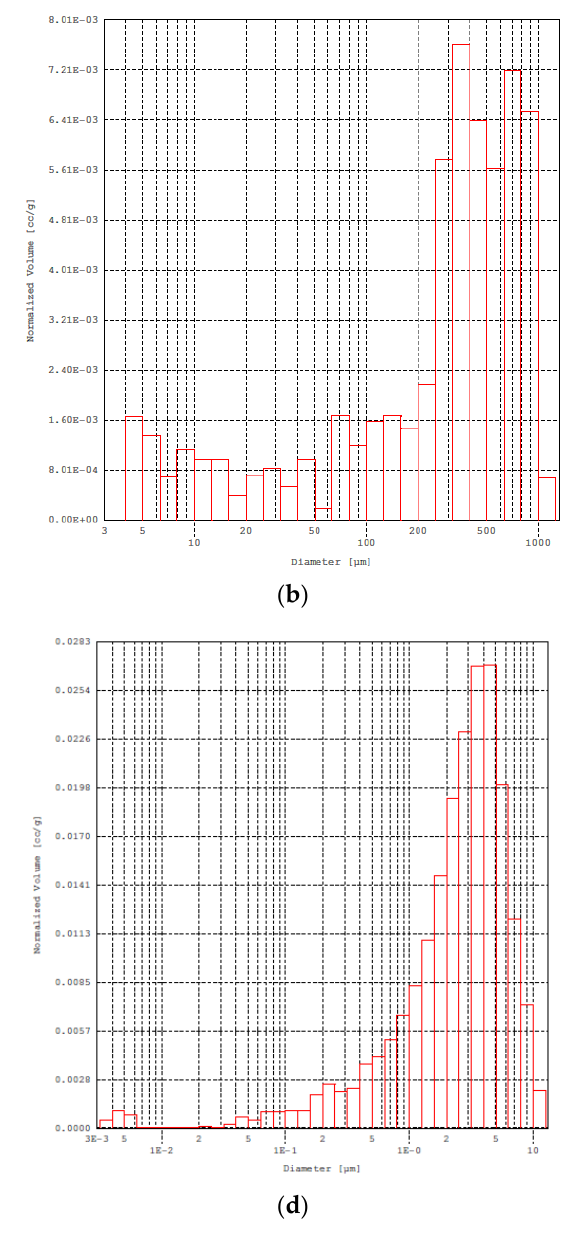
Figure 13. Normalized intraparticle volume vs. pore size histogram in low and high pressure. Intraparticle porosity is shown in red: ( a ) Reference at low pressure; ( b ) MBC-0.4 at low pressure; ( c ) Reference at high pressure; ( d ) MBC-0.4 at high